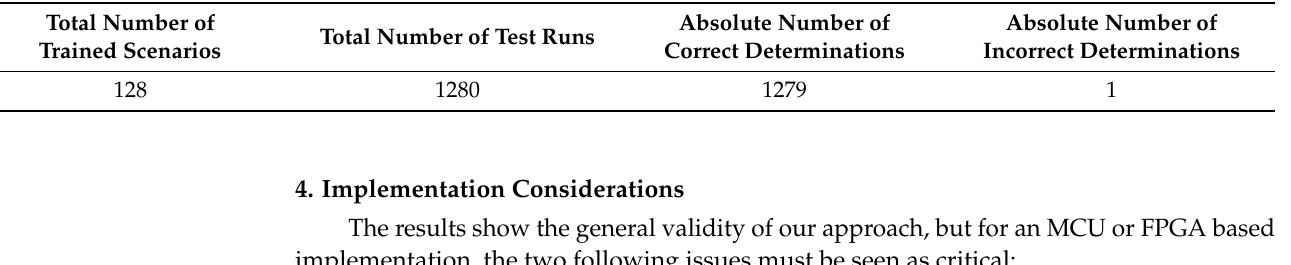
Table 5. Results of the combined execution of the identification and speed estimation task. Total Number of Total Number of Test Runs Trained Scenarios 128